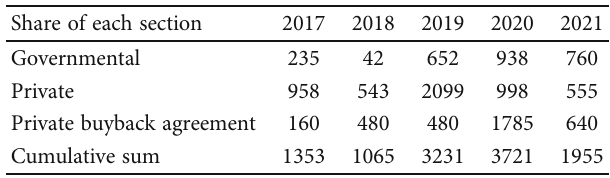
Table 2: Ministry of Energy plans to increase capacity of power plants (MW). Extracted from the Thermal Power Plants Holding Company database.